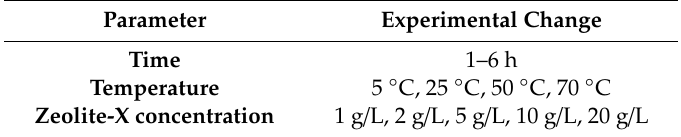
Table 3. The influence factors for the hexavalent chromium ion removal